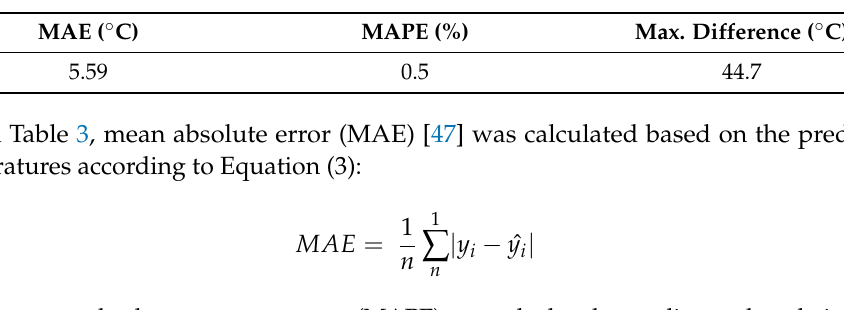
Table 3. Estimated errors of the predicted